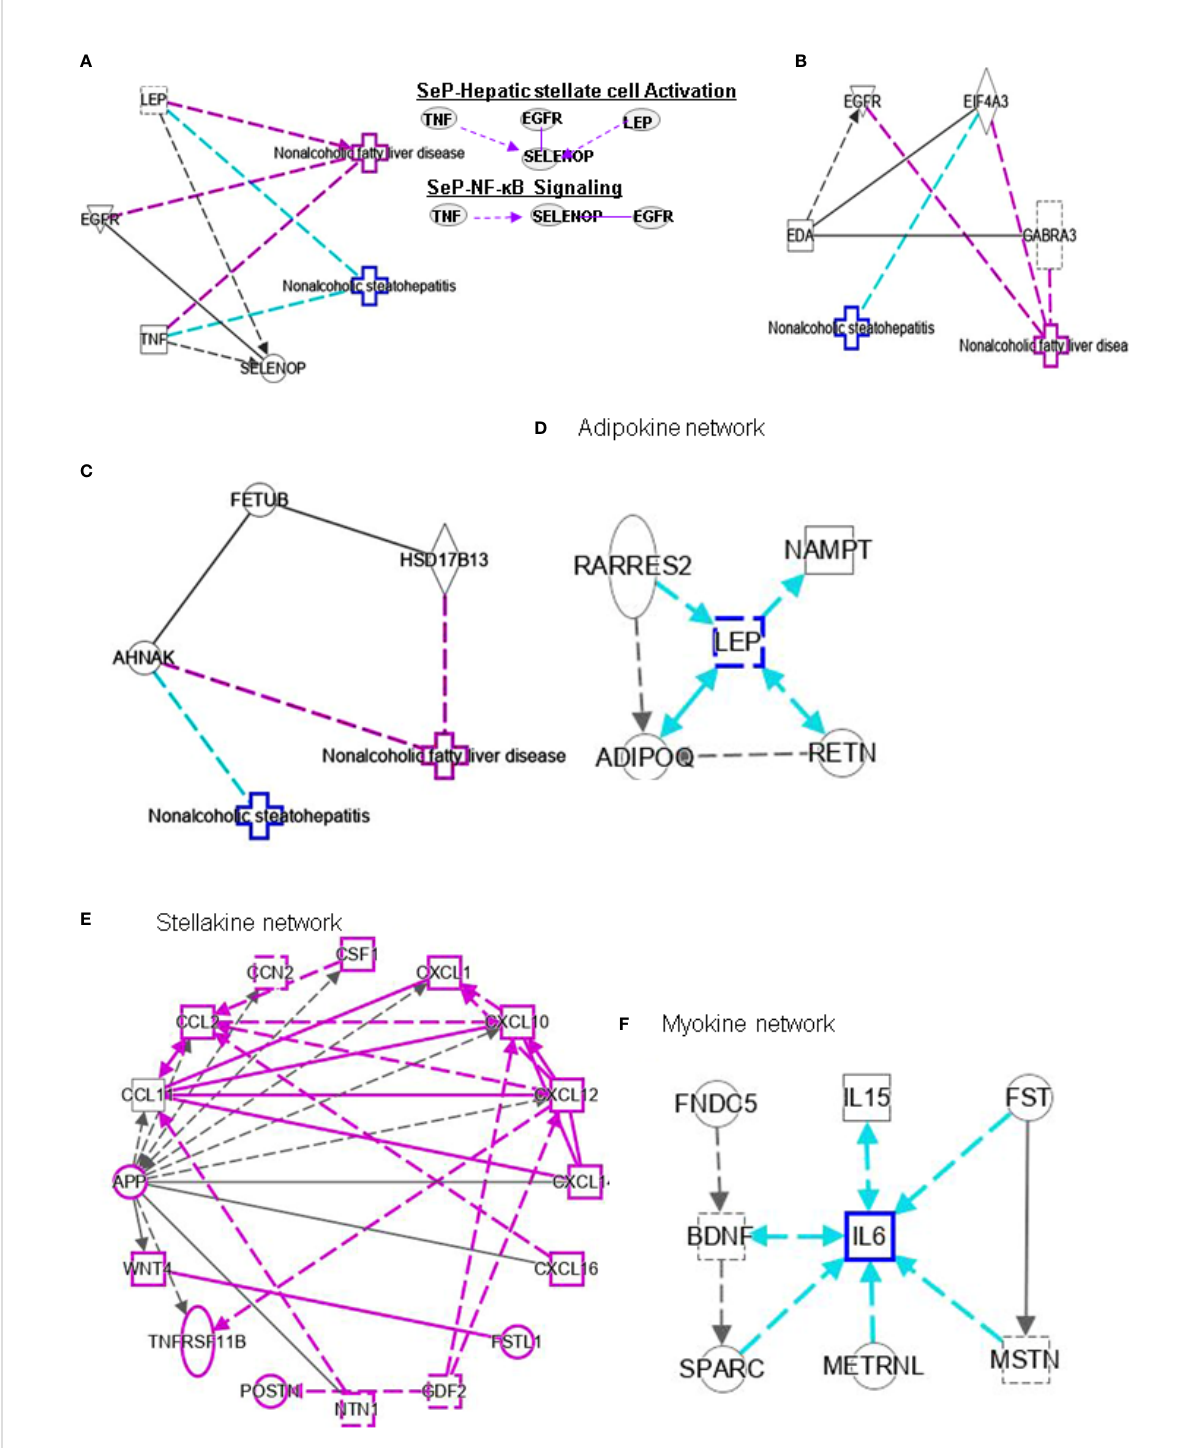
FIGURE 5 Ingenuity pathway analysis (IPA) of SELENOP, EDA and FETUB. (A) IPA investigated the molecular pathways of SELENOP involved in NAFLD and NASH. All identi fi ed pathways of SELENOP were screened individually. Representative canonical pathways of SELENOP are associated with other related genes of NAFLD and NASH. Functional relationships of these genes and SELENOP are depicted using straight lines with arrows. SELENOP is functionally related to 1. Hepatic stellate cell signaling and 2. NF- k B signaling (Right). (B, C) IPA investigated the molecular pathways of EDA and FETUB involved in NAFLD and NASH. All identi fi ed pathways of EDA and FETUB were screened individually. (D – F) IPA investigated the molecular pathways of Adipokine, Stellakine and Myokine